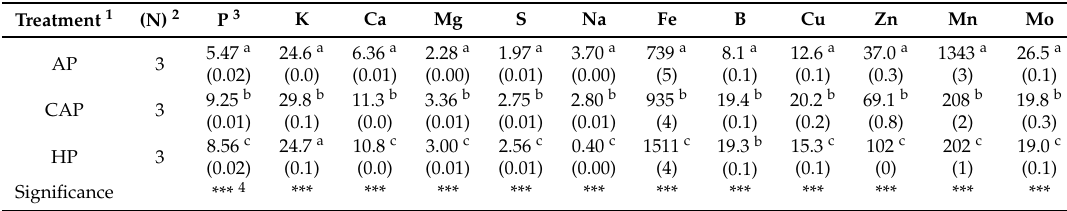
Table 5. LS mean of lettuce leaf nutrient content in trial 2.